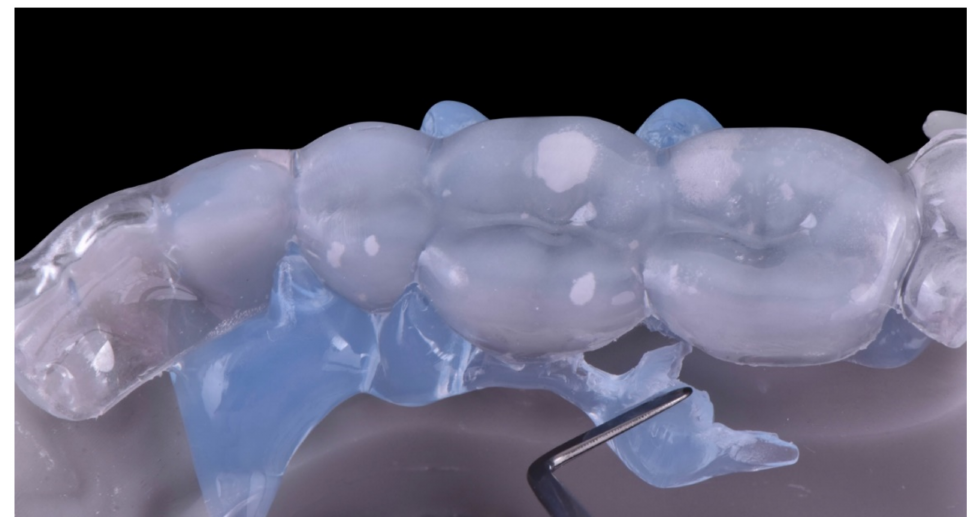
Figure 17. Removal of transparent silicon excesses.